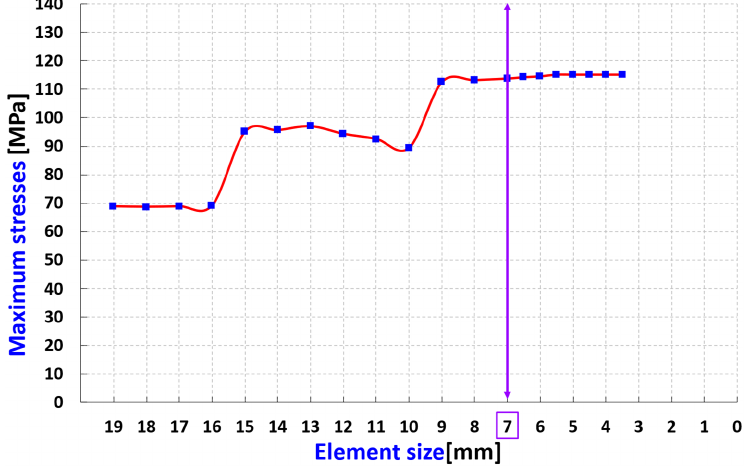
Figure 4. Mesh convergence study—maximum constraints as a function of element size.